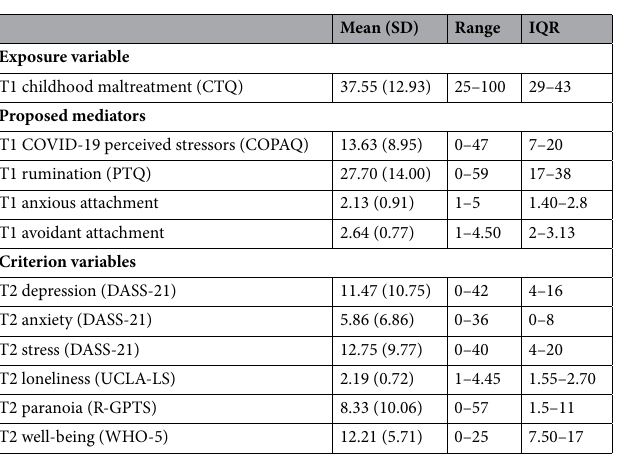
Table 2. Descriptive statistics of exposure, proposed mediator, and psychosocial outcome variables. SD standard deviation, IQR inter quartile